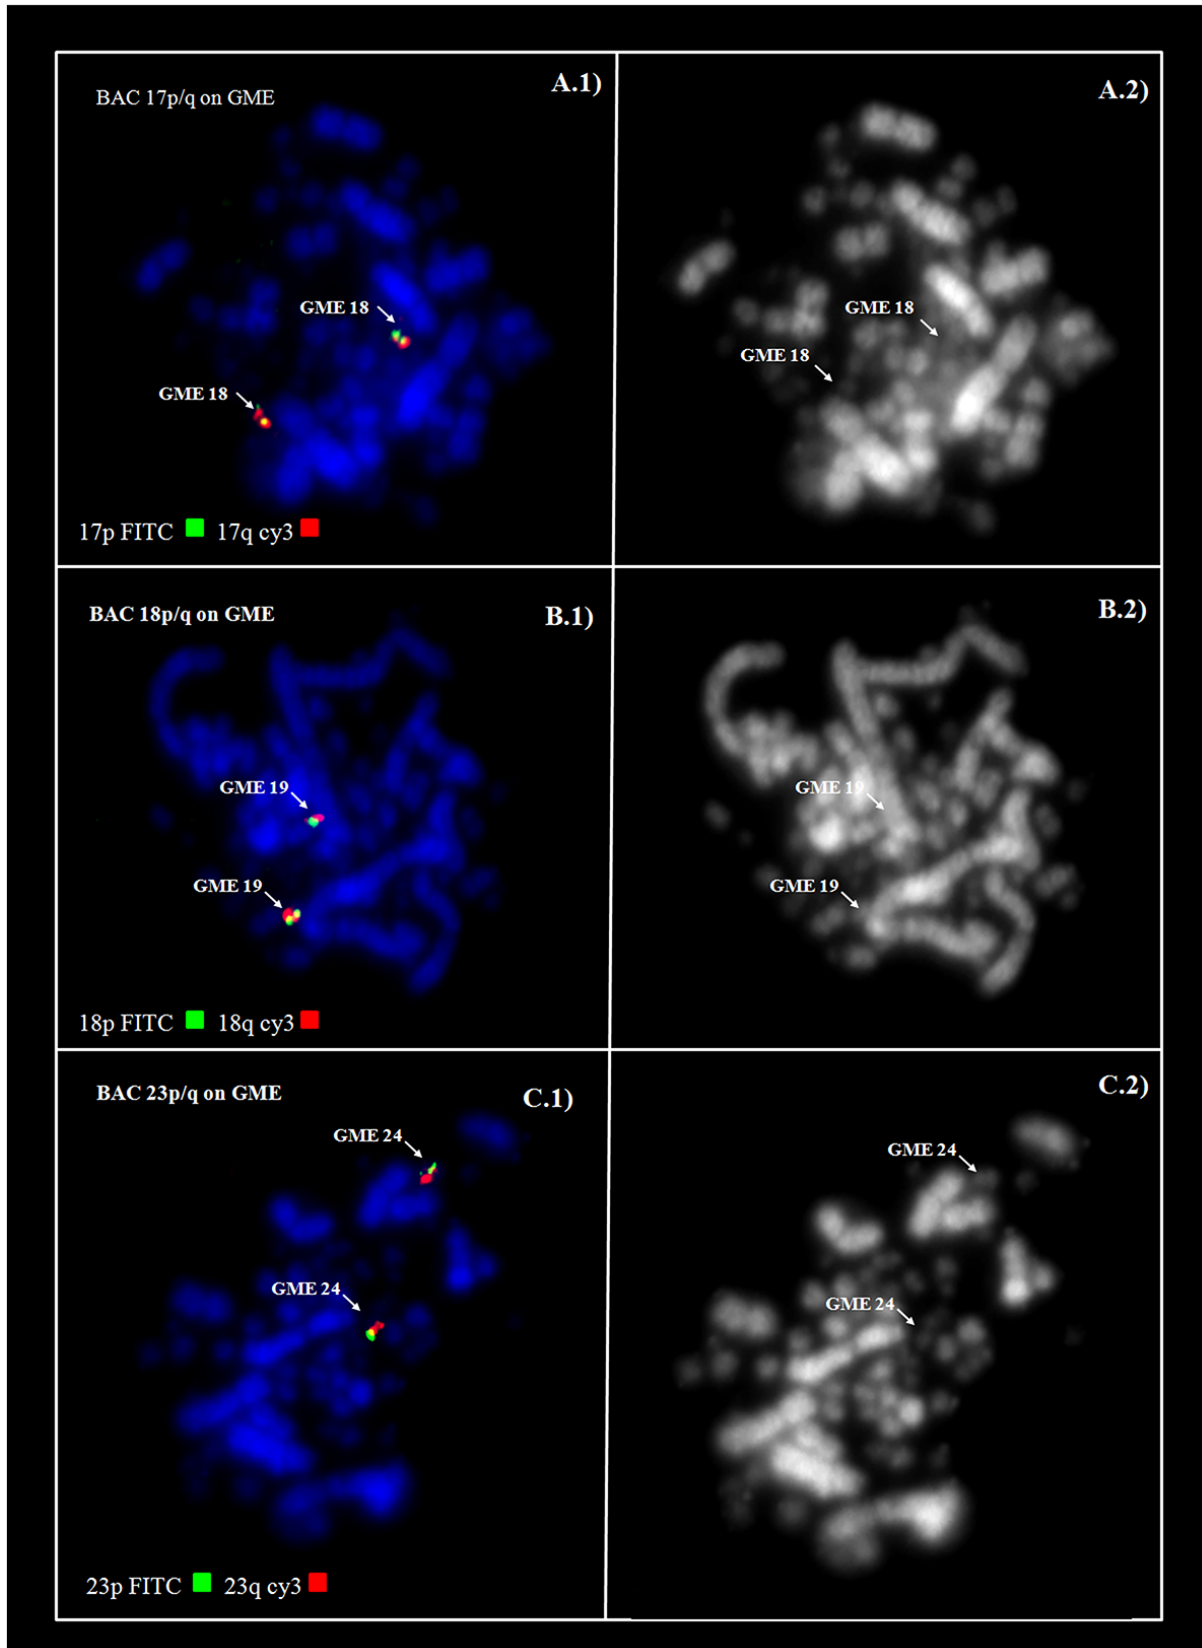
Figure 3 – Homology between chromosomes of Gallus gallus (GGA) and Gallinula melanops (GME) determined by FISH experiments using Chicken BACs from microchromosomes. Examples of conserved microchromosomes can be observed in: A1-A2- BACs 17p/q, B1-B2- BACs 18p/q, C1-C2- BACs